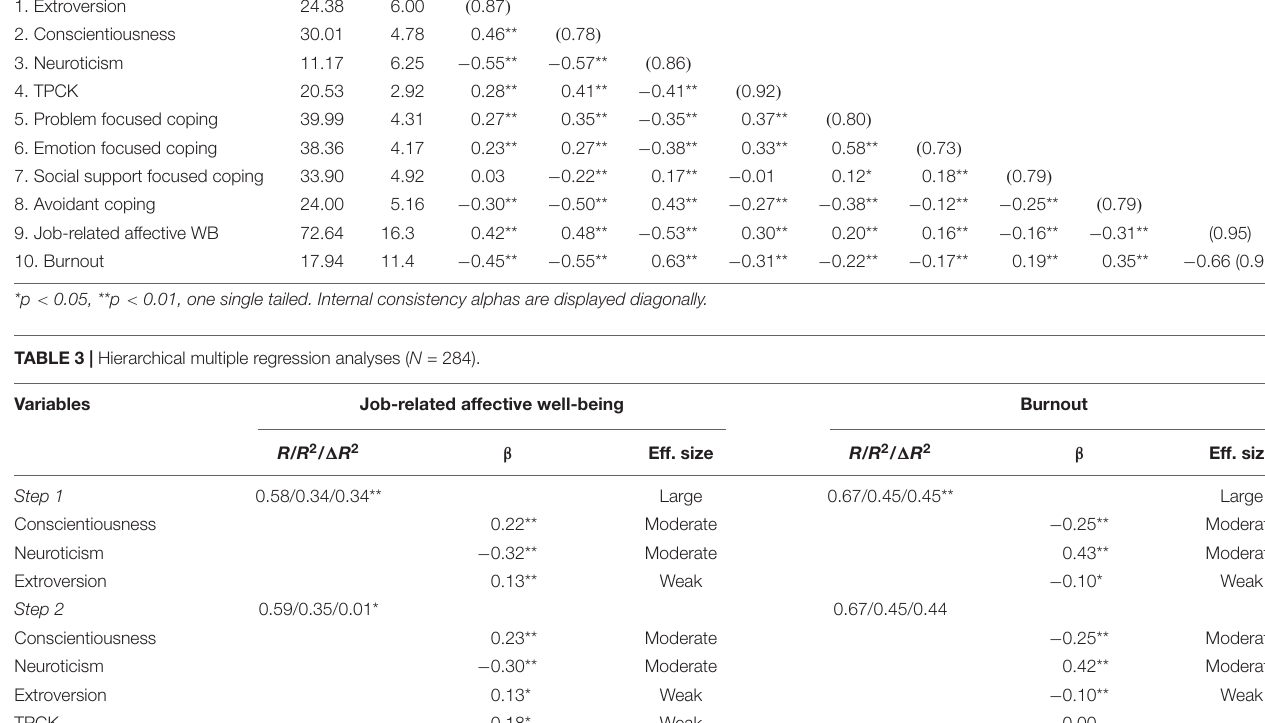
TABLE 2 | Means, standard deviations, and correlation coefficients between variables ( N = 284). Variables